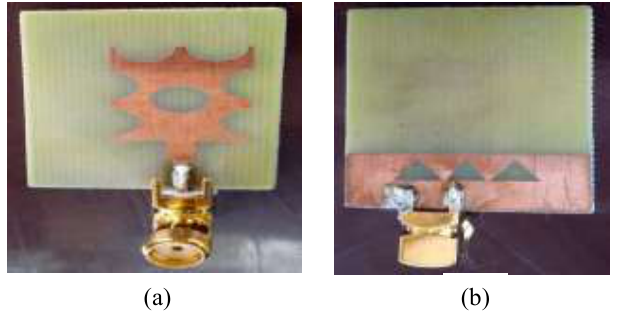
Figure 14: Fabricated prototype (a) Top view